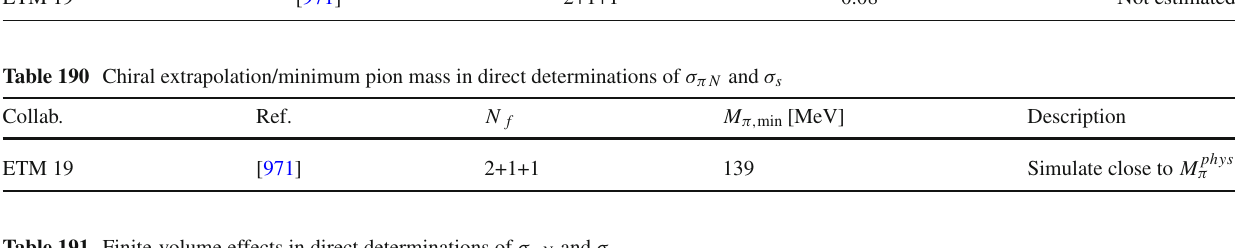
Table 191 Finite-volume effects in direct determinations of σ π N and σ s Collab.